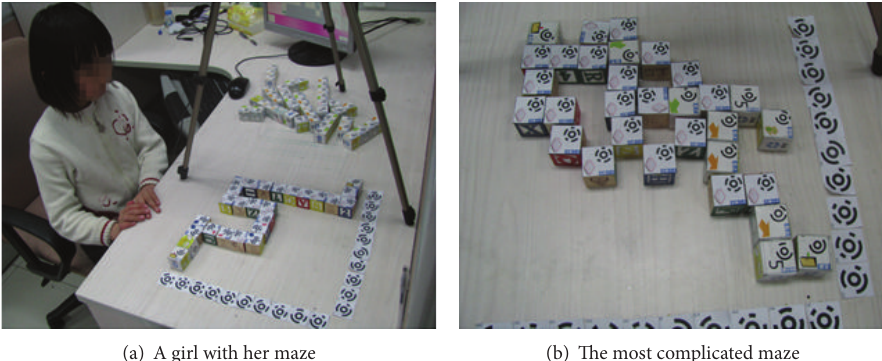
Figure 7: Two mazes collected from maze creation session: a girl with her maze (a) and the complicated maze created by a boy